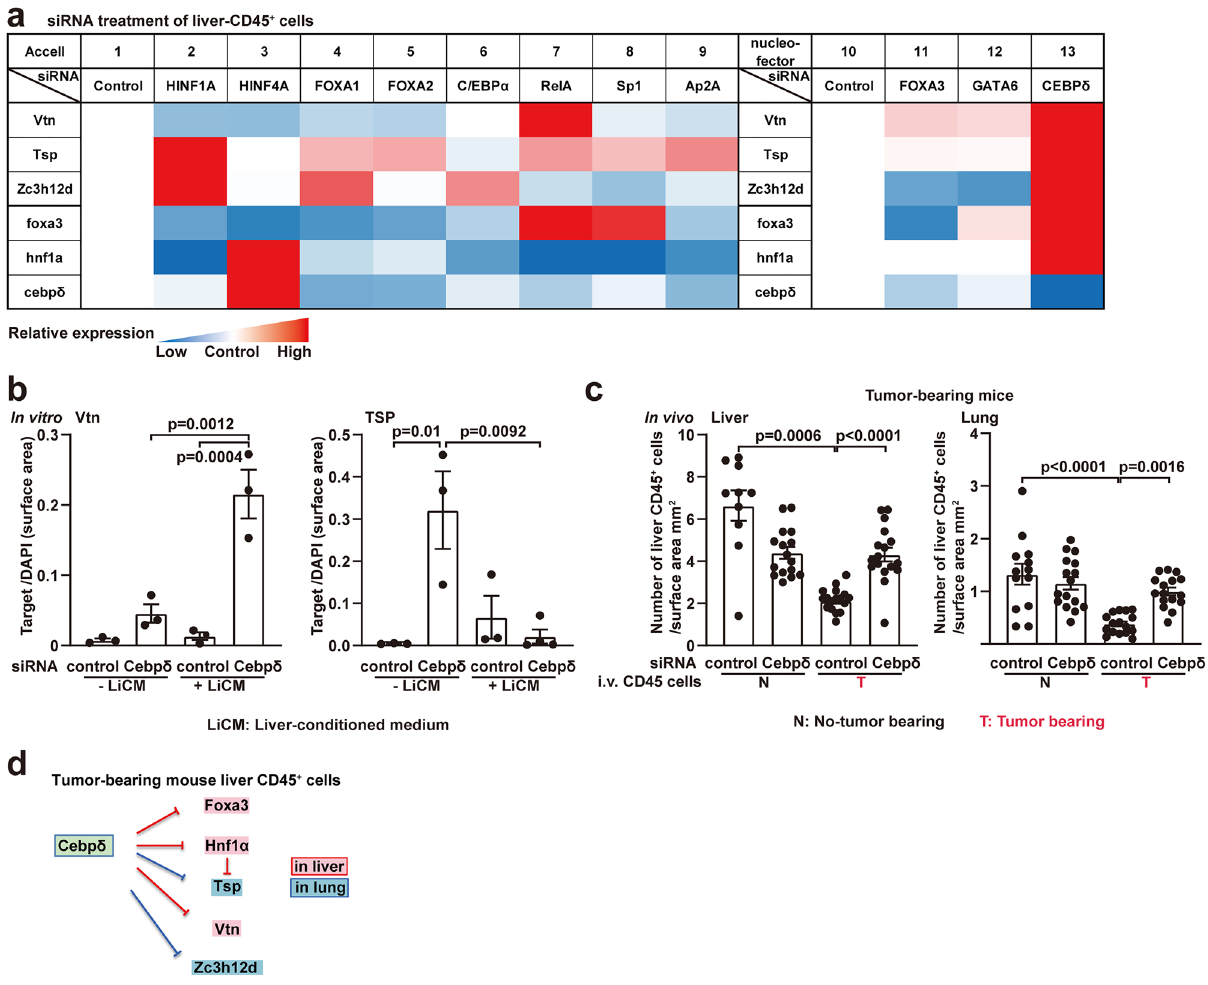
Figure 3. Primary tumor-stimulating CEBPδ regulates Vtn, Tsp, and ZC3H12D in the tumor-bearing liver and lungs. ( a ) Heatmap of mRNA levels in liver CD45 + cells treated with siRNA based on Supplementary Fig. S6. One of the two distinct siRNA delivery systems was utilized for each siRNA (transfection “Accell” and electroporation “Nucleofector”) and evaluated with control (nontarget) siRNA. ( b ) Protein levels of Vtn and Tsp in siRNA-treated tumor-bearing liver CD45 + cells cultured with/without a liver-conditioned medium (LiCM) derived from tumor-bearing mice. DAPI normalized immunohistochemical signals. N = 3. ( c ) Number of accumulated siRNA-treated liver CD45 + cells in the liver (left) and lung (right) after injection in E0771-bearing recipient mice. Red words indicate substantial results. N = 8 (1–2 tissue lobes in each mouse). Error bars indicate the mean ± SEM, and P values (significant) are indicated in graphs ( a – c ). ( d ) Summary of CEBPδ inhibitory regulation in tumor-bearing mouse liver CD45 + cells using an in vitro siRNA assay, per the data shown in Supplementary Fig.